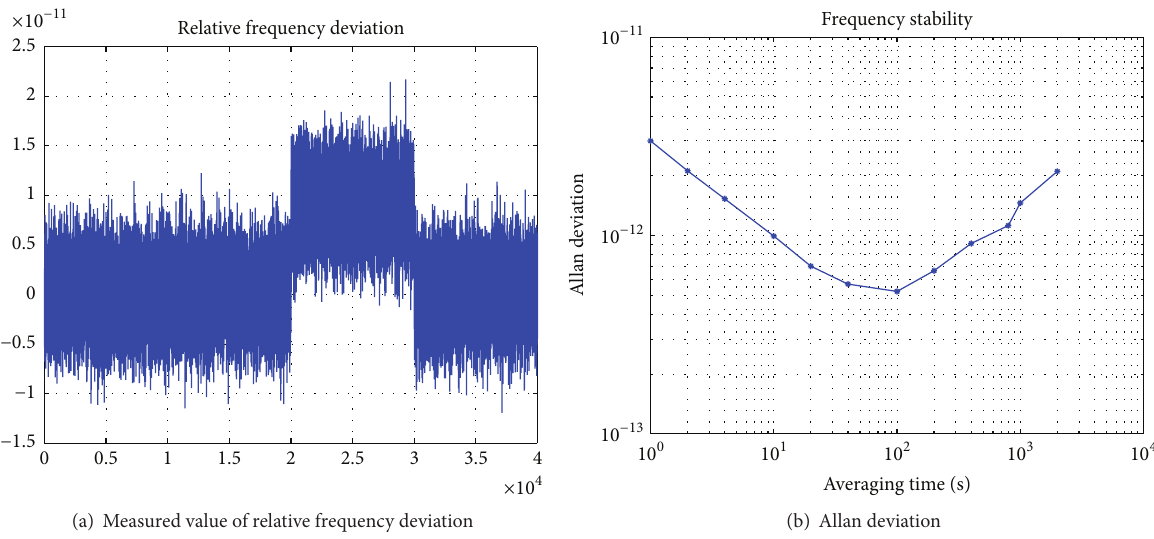
Figure 6: Relative frequency deviation and its Allan deviation when anomaly